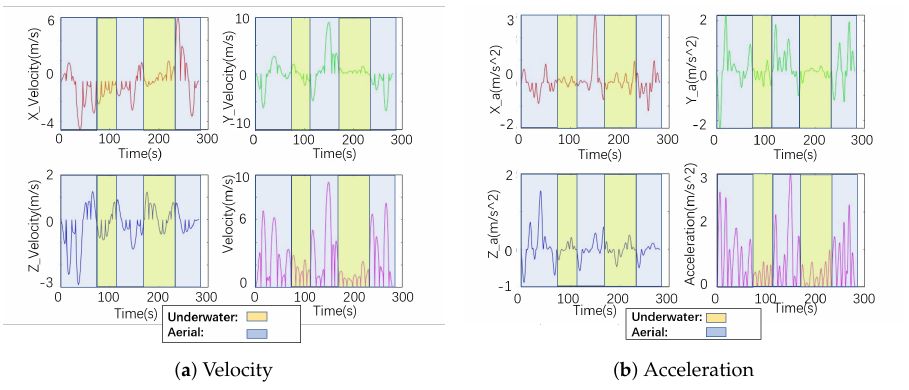
Figure 17. The velocity and acceleration of one HAUV on a typical mission. The underwater and aerial modes can be distinguished from this figure: aerial velocity and acceleration constraints are looser than underwater condition